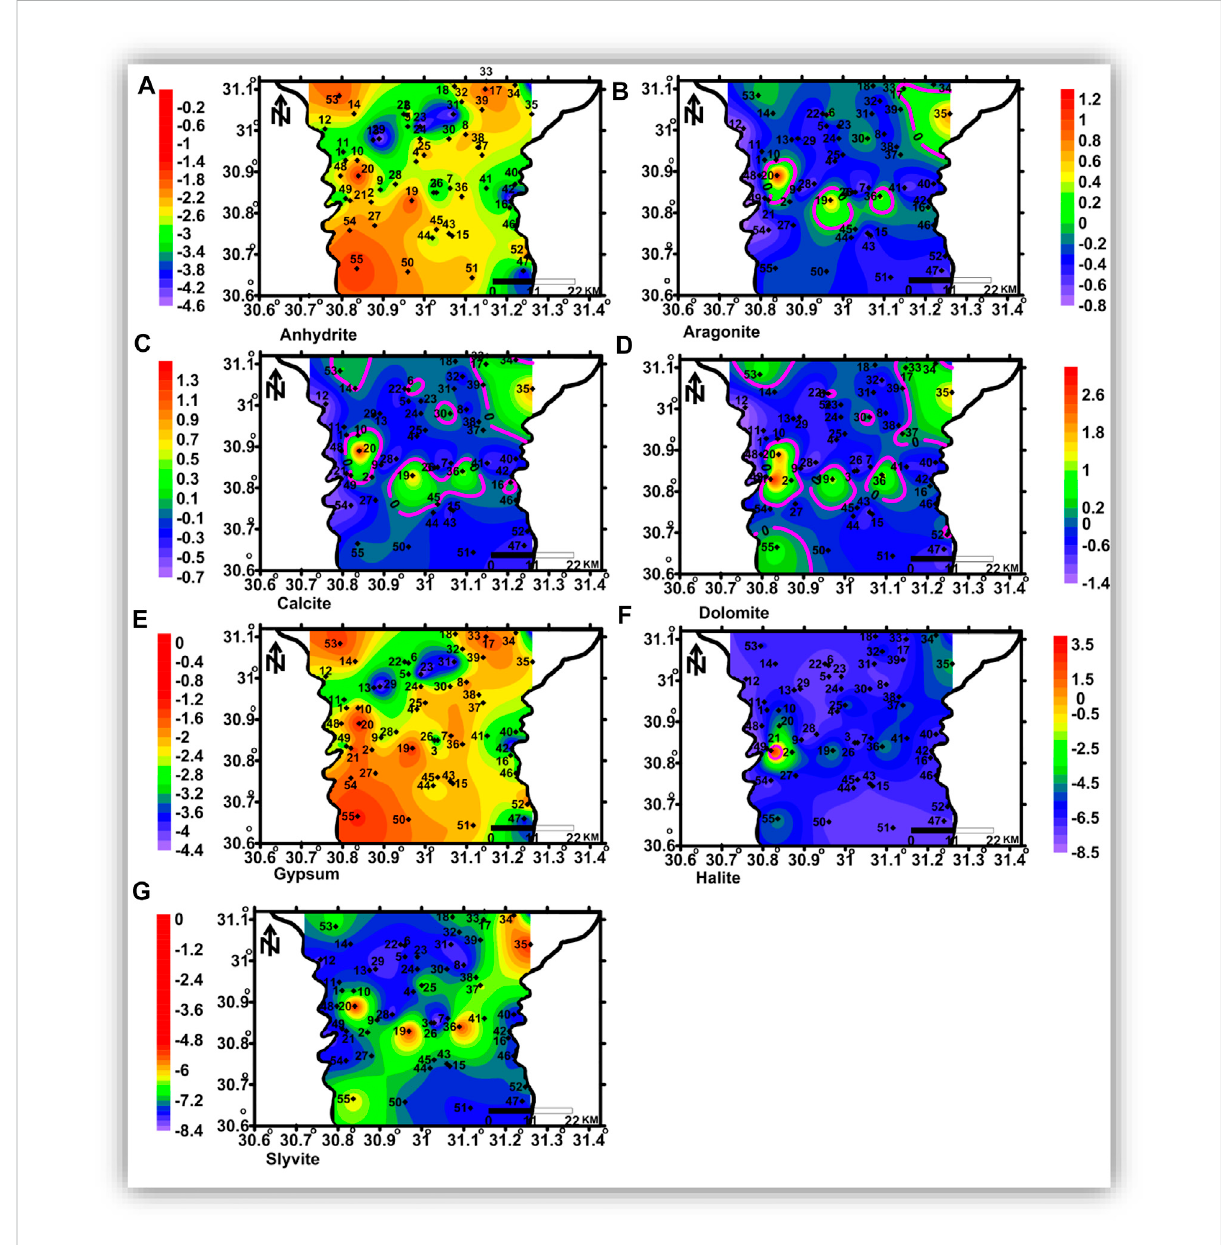
FIGURE 13 Spatial distribution maps of the dissolved minerals ’ saturation indices in the shallow